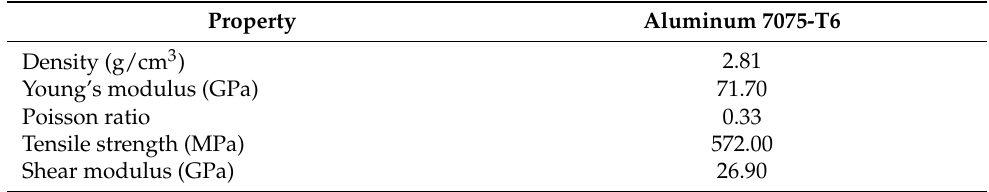
Table 1. Physical and mechanical properties of original component (supplied by KMS – Technical Material, Lda.